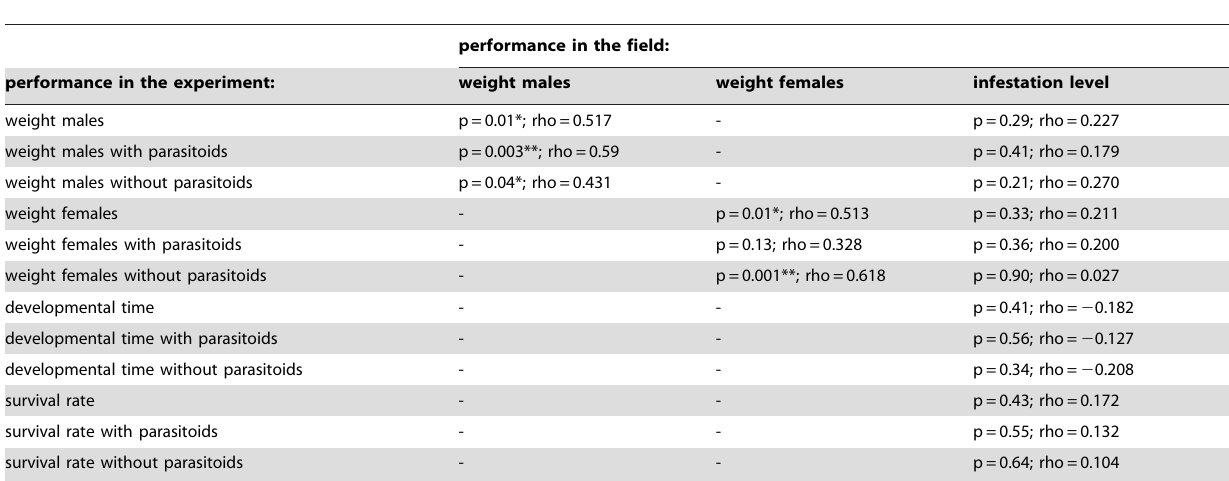
Table 4. Correlation between laboratory and field performance of Acanthoscelides